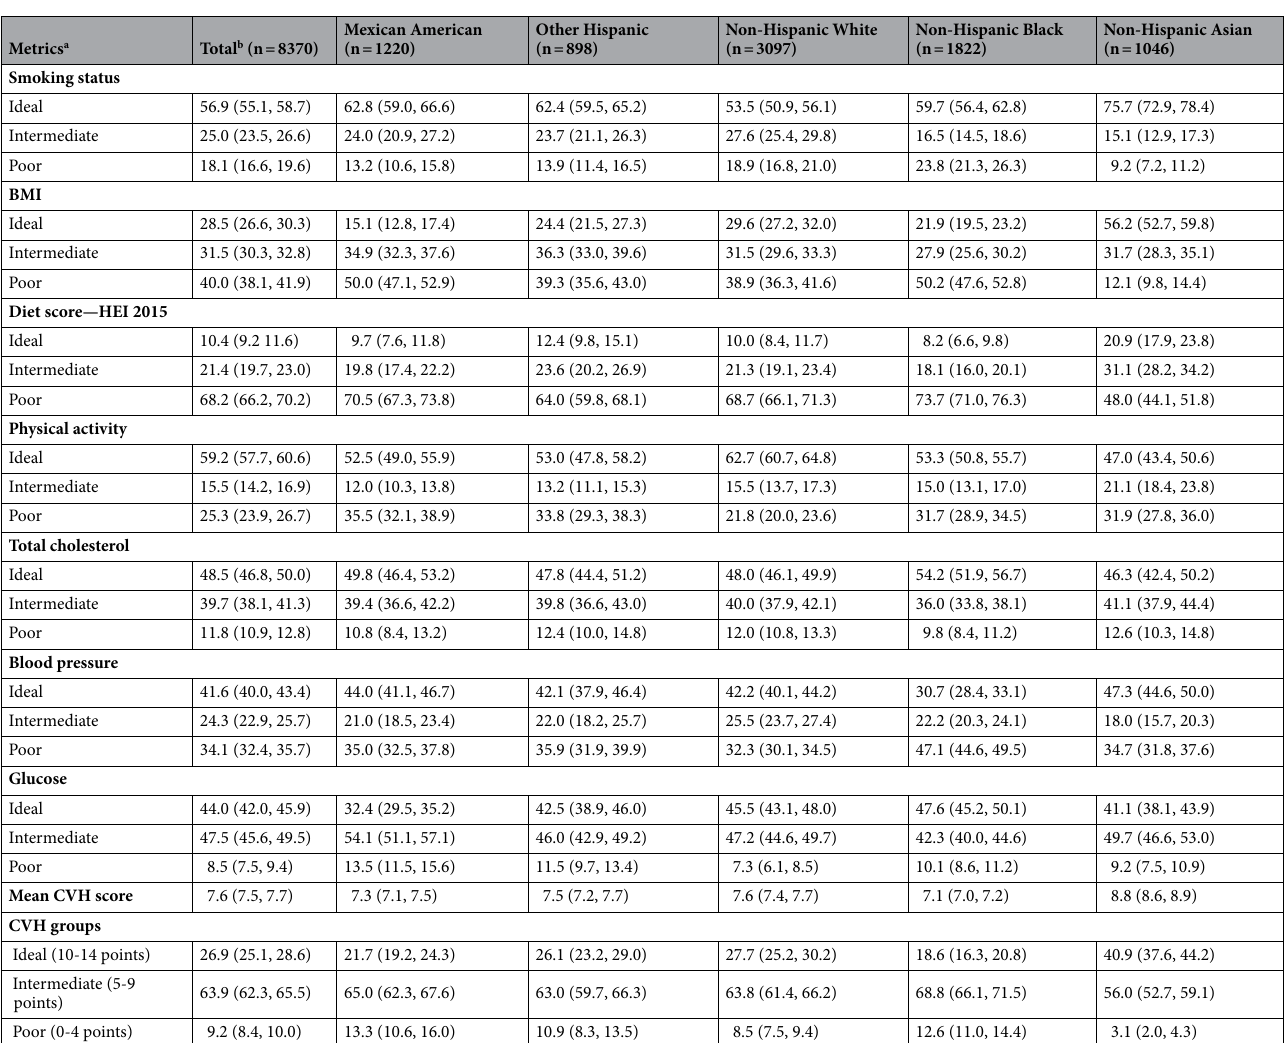
Table 3. Age-standardized prevalence of cardiovascular health metrics for adults ≥ 20 years by race/ethnicity. BMI body mass index, HEI healthy eating index, SBP systolic blood pressure, DBP diastolic blood pressure, CVH cardiovascular health, CVHM cardiovascular health metric. a Metrics defined as, smoking status: Ideal (never), Intermediate (former), Poor (current); BMI: Ideal (< 25 kg/m 2 , Intermediate (25–29.9 kg/m 2 ), Poor (≥ 30 kg/m 2 ); Diet-HEI 2015 score: Ideal (> 69.3), Intermediate (56.9–69.3), Poor (< 56.9); physical activity: Ideal, (≥ 150 min/wk moderate or ≥ 75 min/wk vigorous or ≥ 150 min/wk moderate + vigorous), Intermediate (1–149 min/wk moderate or 1–74 min/wk vigorous or 1–149 min/wk moderate + vigorous), Poor (none); total cholesterol: Ideal (< 200 mg/dL), Intermediate (200–239 mg/dL or treated to goal), Poor (≥ 240 mg/dL); blood pressure: Ideal (SBP < 120 and DBP < 80 mmHg), Intermediate (SBP 120–129 and DBP < 80 mmHg or treated to goal), Poor (SBP ≥ 130 or DBP ≥ 80 mmHg); Glucose: Ideal (< 100 mg/dL), Intermediate (100–125 mg/dL or treated to goal), Poor (≥ 126 mg/dL). Statistics are displayed as Percent (95% Confidence Interval). b All values (except mean CVH score) are weighted percentages, and age standardized to Census 2010 US